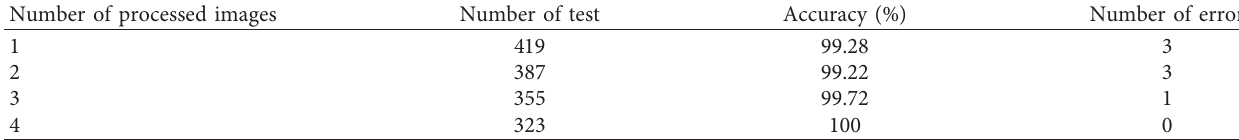
Table 5: Ego-lane identification results according to the number of processed images. Number of processed images